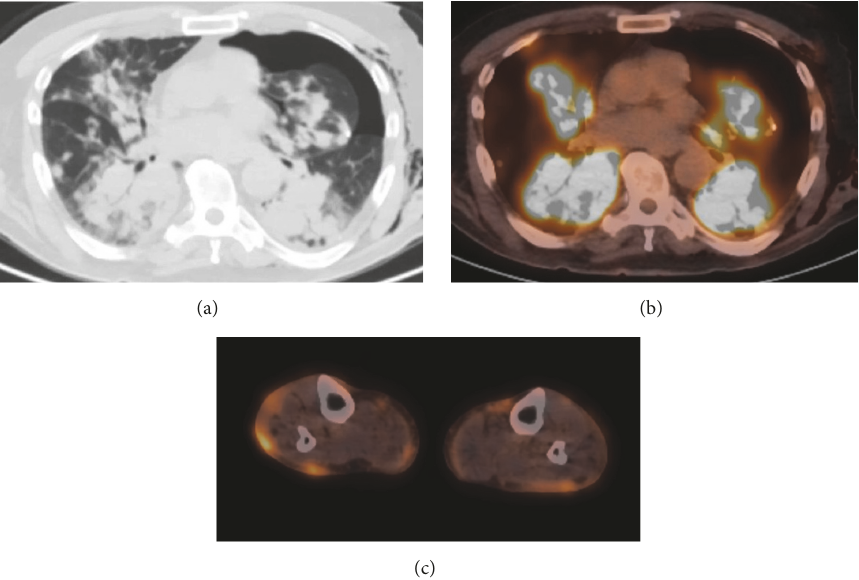
Figure 4: Axial images from PET/CT obtained 4 weeks following baseline chest CT. Axial CT image in lung windows (a) shows marked progression and confluence of bilateral peribronchovascular lung opacities. Fused PET/CT image of the thorax (b) shows the pulmonary abnormalities to have intense FDG uptake with max SUV of 22.3. There were no FDG-avid lymph nodes or splenomegaly. Left pneumothorax and subcutaneous emphysema were a result of the patient’s recent VATS biopsy. Axial fused image of the lower extremities (c) shows FDG uptake within multiple subcutaneous